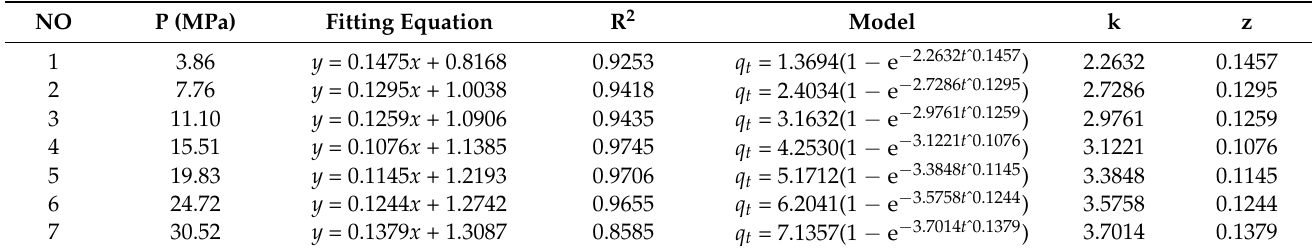
Figure 5. Fitting methane adsorption dynamic using Bangham model at 30 °C. Table 1. The results of fitting methane adsorption dynamic using Bangham model at 30 ◦ C.